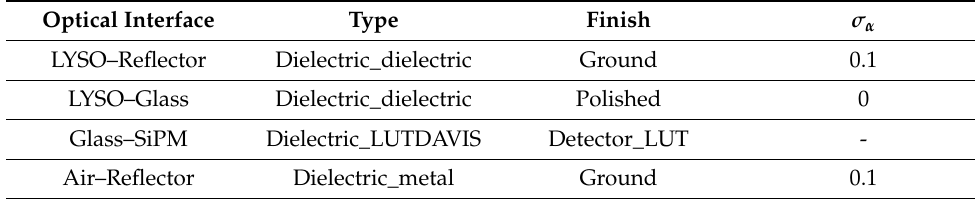
Table 3. Type, finish, and σ α value for each optical interface.